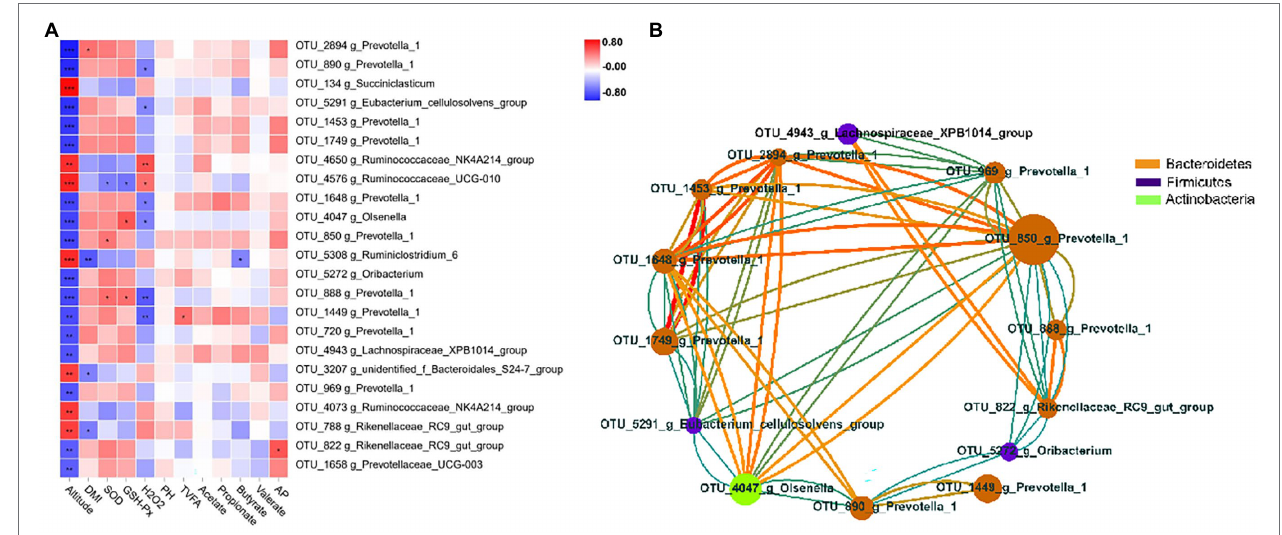
FIGURE 4 | Correlation analysis of rumen bacteria. (A) Heatmap of core operational taxonomic units (OTUs) (relative abundance >0.01% and p < 0.05 in all samples) significantly associated with production and fermentative parameters of feces in low- and high-altitude Sanhe heifers, as determined using the Spearman’s correlation analysis. *0.01 < p < 0.05; **0.001 < p < 0.01; and *** p ≤ 0.001. (B) Interaction among relative abundance >0.01% and p < 0.05 of OTUs (red = positive correlation; blue = negative correlation; size and color of circles = relative abundance of OTUs and the genus to which they belong, respectively).